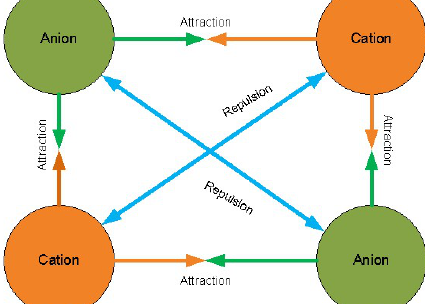
Fig. 1 . Conceptual model of the force of attraction and